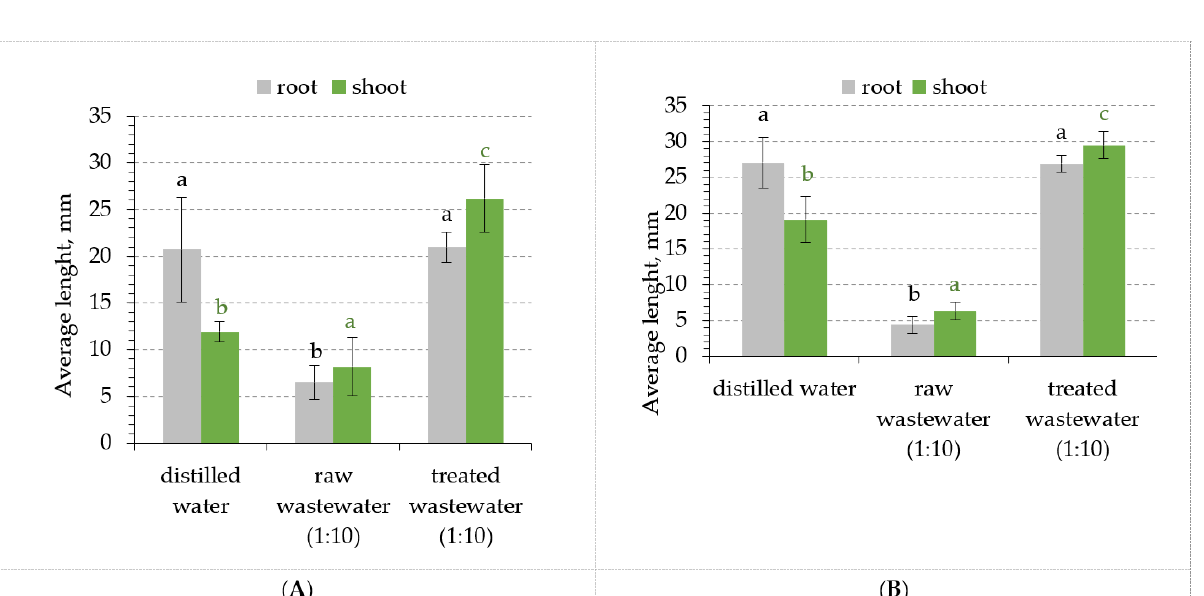
Table 10. Results of one-way ANOVA test for phytotoxicity tests.